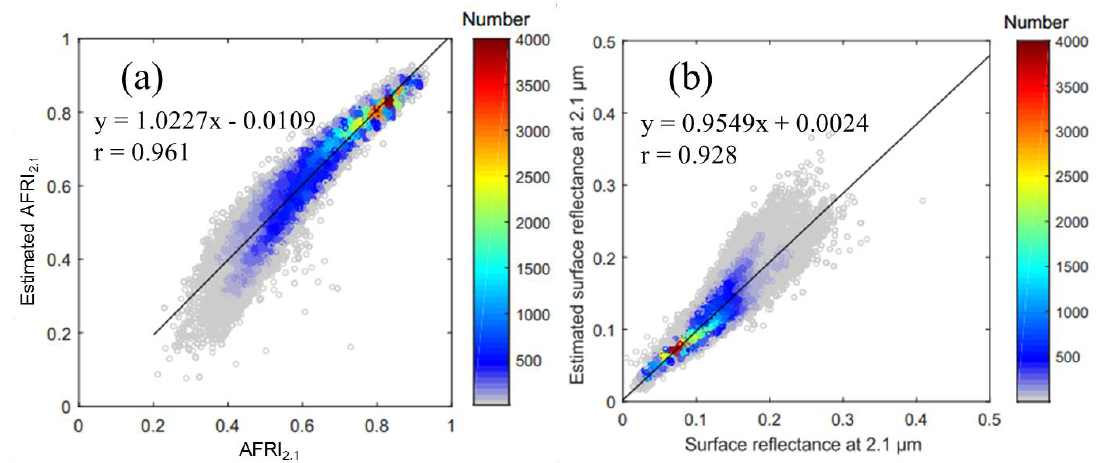
Figure 6. Comparisons of the estimated results and the true values. ( a ) Comparisons of the estimated AFRI 2.1 and the true AFRI 2.1 ; ( b ) Comparisons of the estimated and the true surface reflectance at 2.1 μm. The estimated surface reflectance at 2.1 μm is from the AFRI 2.1 estimated using the proposed method (Equations (11)–(14)). The color bars show the number for each point.